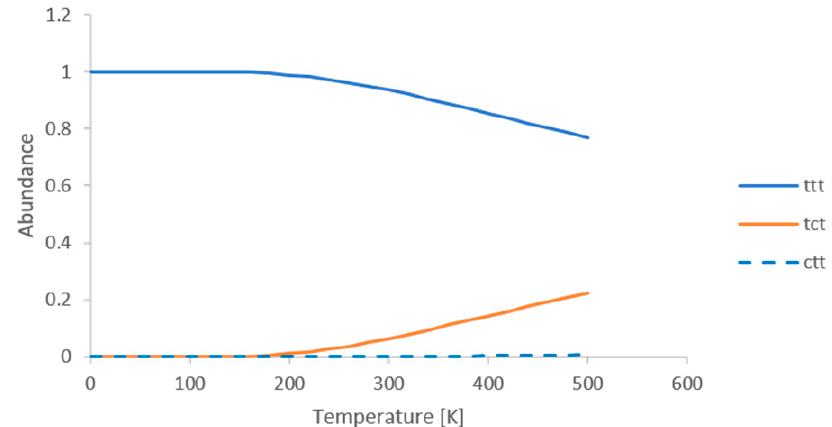
Figure A4. Conformational abundance of the ttt, tct and ctt conformers using a Boltzmann distribution in function of the temperature (B3LYP/cc-pVDZ data).